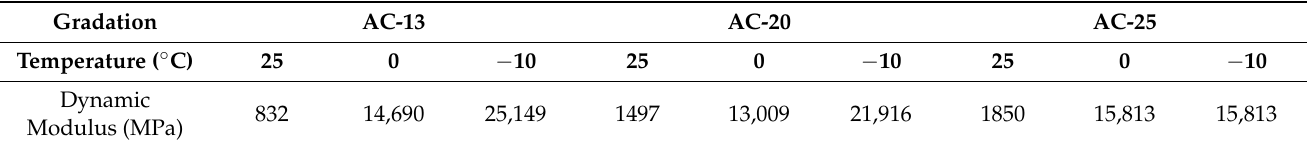
Table 3. Dynamic modulus at different gradations and temperatures.